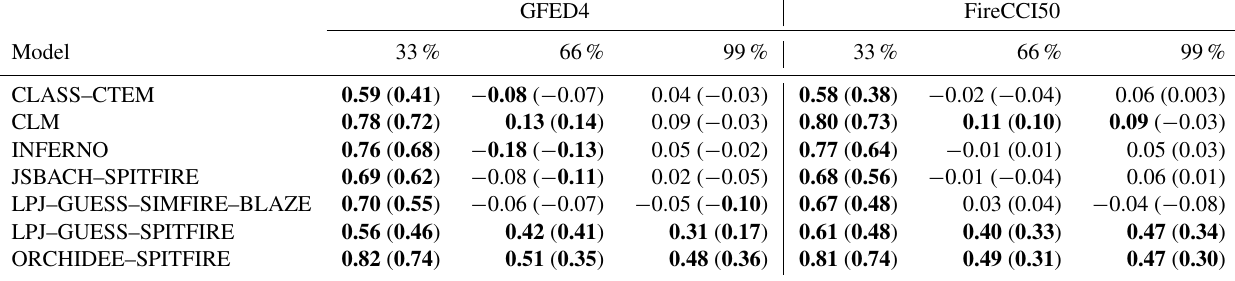
Table A2. Correlation coefficients between burned area simulated by the FireMIP models within the baseline experiment SF1 and the respective observation data. Due to the very skewed distribution of burned area, we use a square root transformation on both the models and the observations. Numbers in brackets show the Pearson correlation coefficients for not-transformed data. Only GFED4 and FireCCI50 provide uncertainty estimates; therefore GFED4s is not included. Correlation coefficients for 33% show the correlation between all grid points that lie within the 0% and 33% percentile of the relative standard error. Values for 66% lie within the 33%–66% percentile of the relative standard error, and values for 99% lie within the 66%–99% percentile. Bold numbers indicate correlation coefficients that are significant ( p value < 0 .